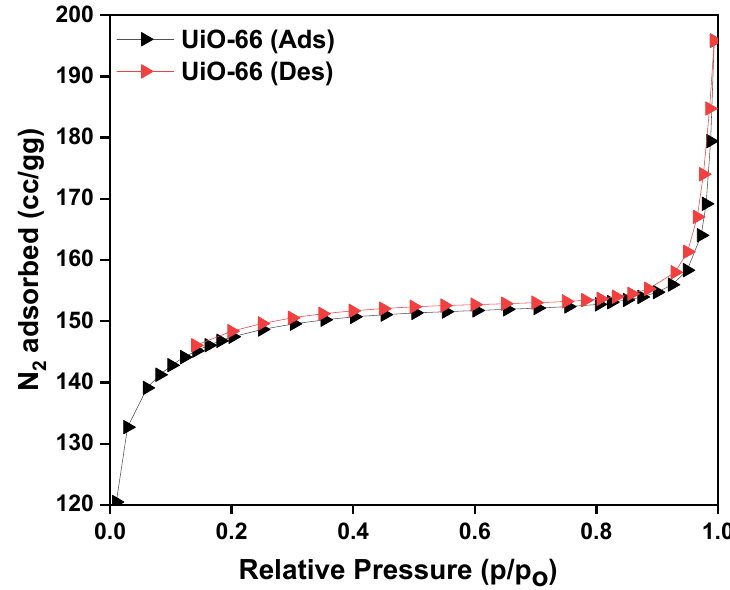
Figure 4. N 2 adsorption isotherm graphs of